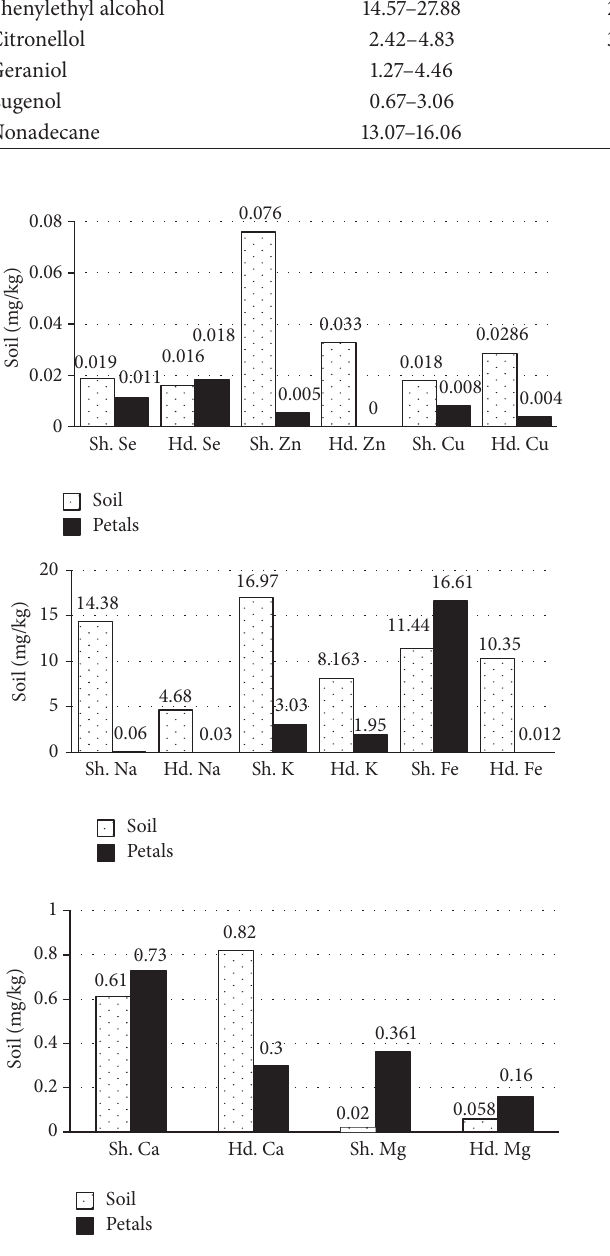
Figure 2: Comparison between the levels of elements in soil and petals.